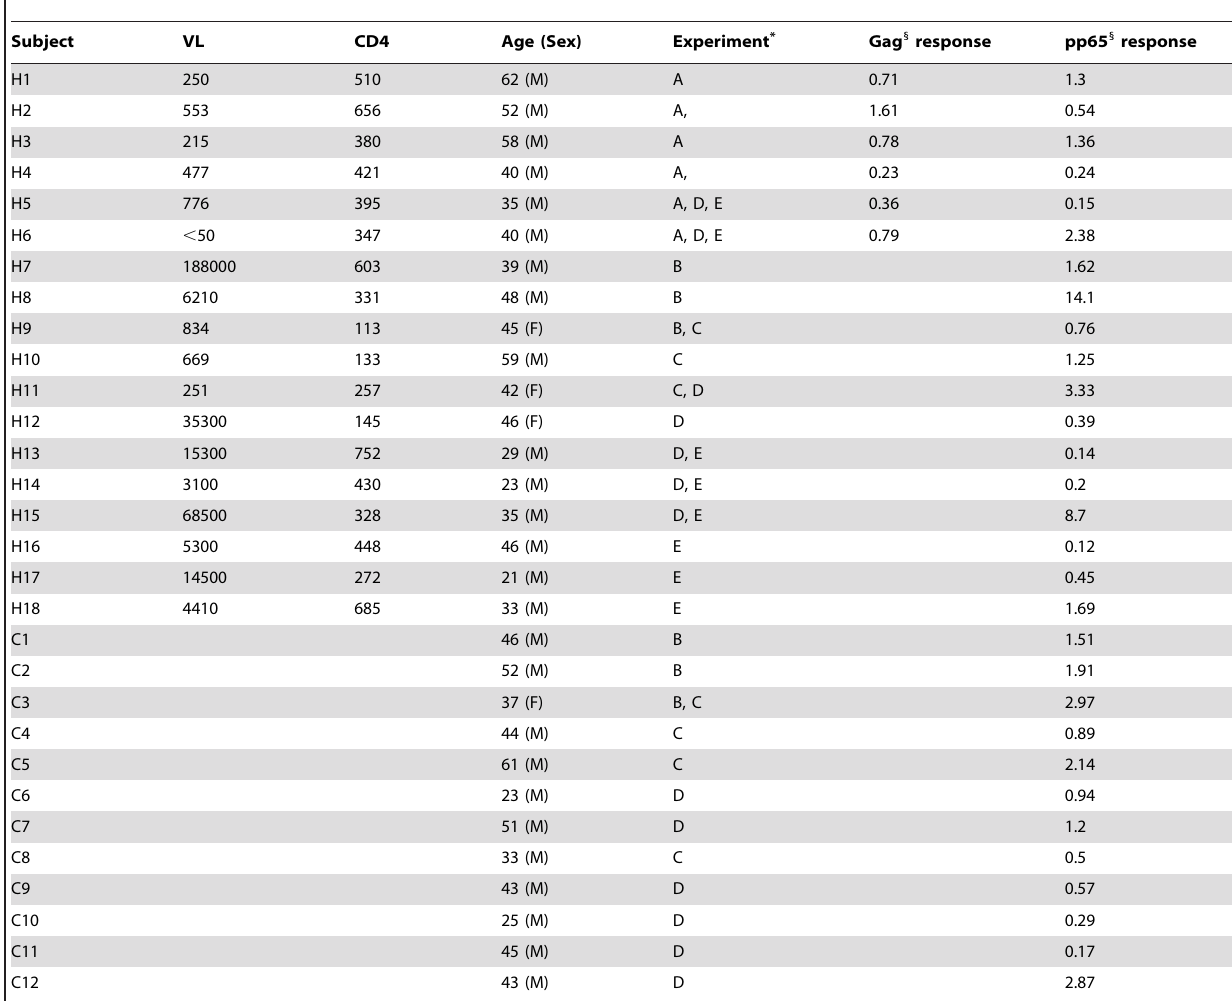
*(A) indicates PBMC used for the functional analysis shown in Figure 1, 2, and 3. (B) indicates PBMC used for the determination of the production of MIP-1 a , MIP-1 b , RANTES, and IFN c shown in Figure 4A. (C) indicates PBMC used for the determination of relative amounts of MIP-1 a , MIP-1 b , RANTES, and IFN c mRNA shown in Figure 4B. (D) indicates PBMC used for the determination of surface CCR5 expression shown in Figure 5. (E) indicates PBMC used for the determination of cell associated Gag DNA shown in Figure 6. 1 Gag and pp65 responses are given as a percent of the total CD4 + population.